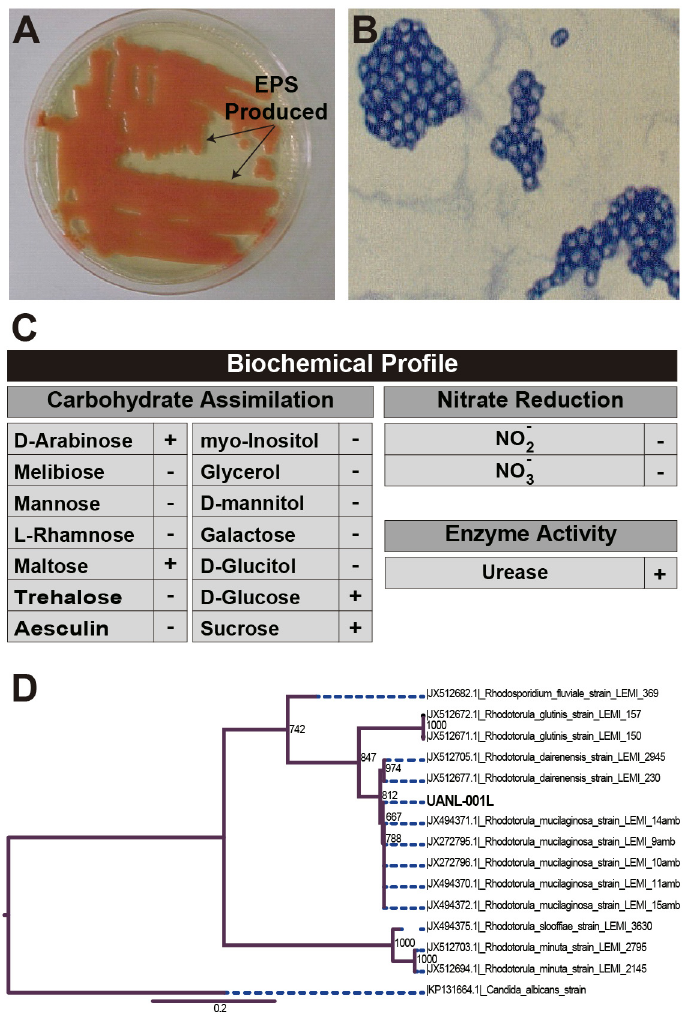
Fig 1. Physical Characteristics and Biomolecular Characterization of the Native Strain Rhodotorula mucilaginosa strain UANL-001L. A) Image showing pink pigmentation of the colonies. Surrounding the colonies the formation of exopolysaccharides can be appreciated as a diffused transparent slime. B) Microscope image at x1000 using Gram-staining and showing yeast at very dense colonies with oval shapes and without the formation of pseudohyphae. C) Biochemical Profile that analyzes assimilation of carbohydrates, nitrogen sources and urea. D) Maximum likelihood phylogenetic tree representing the phylogeny relationship between the UANL-001 strain and other rRNA ITS1 – 5.8S-ITS2 sequences of reported Rhodotorula species . The clades show reciprocal monophyly. The UANL-001 strain was grouped in the monophyletic clade corresponding to Rhodotorula mucilaginosa (Boostrap =